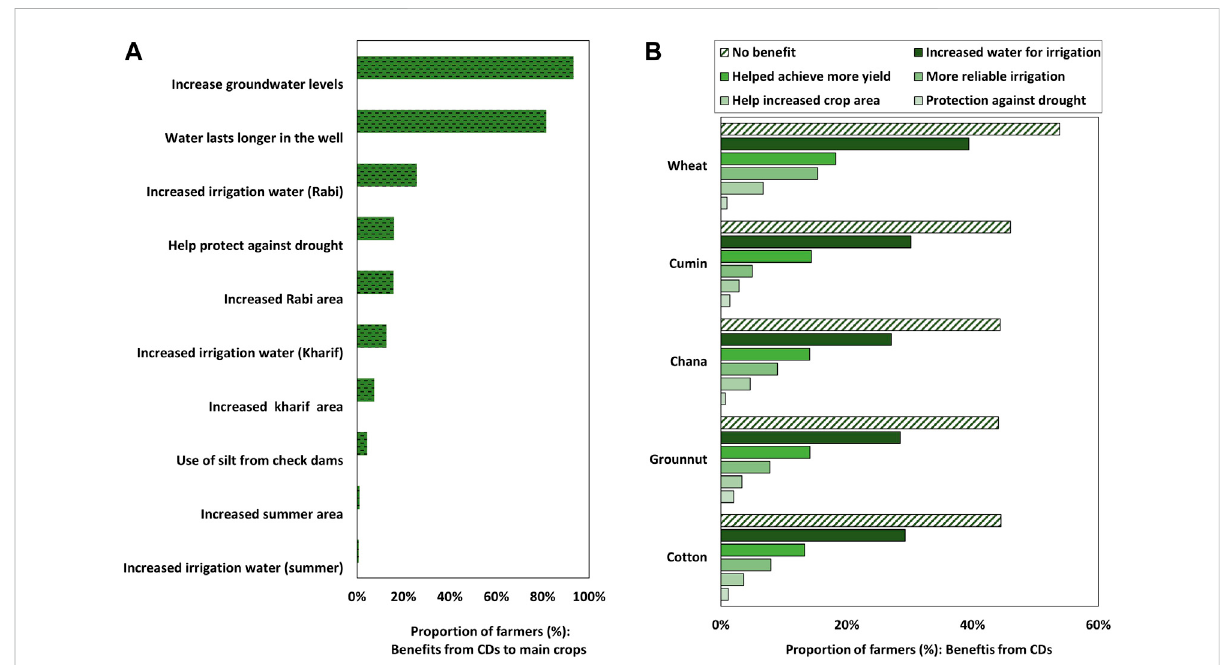
FIGURE 2 (A) Distribution(asaproportionoffarmers)oftheoverallreportedbene fi tsfromCDs; (B) Distribution(asaproportionoffarmers)ofthereported bene fi ts from CDs to main crops.